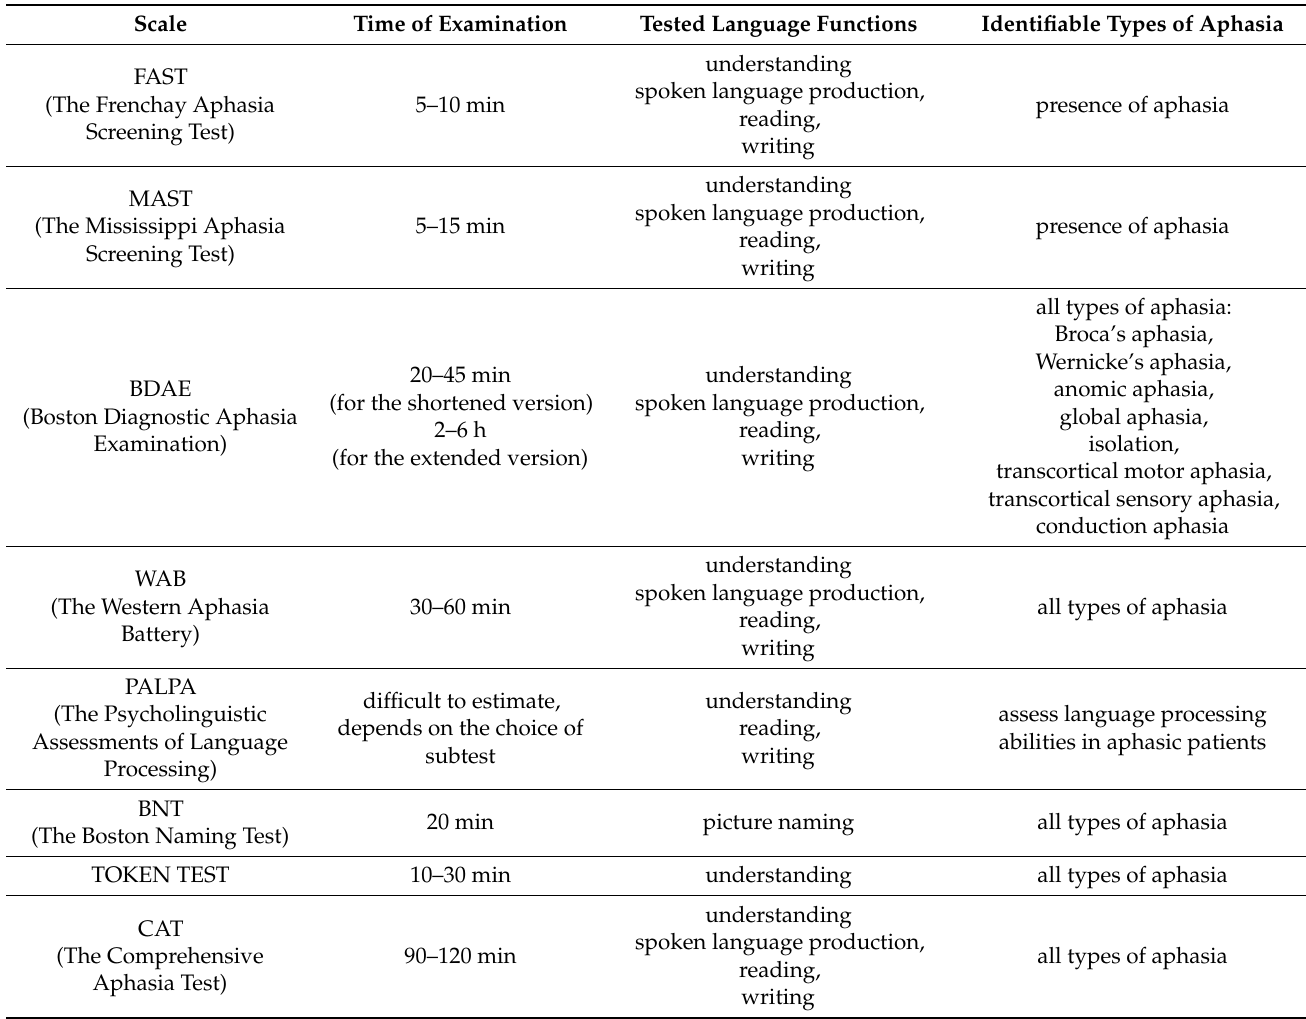
Table 1. A set of standard tests to assess aphasia